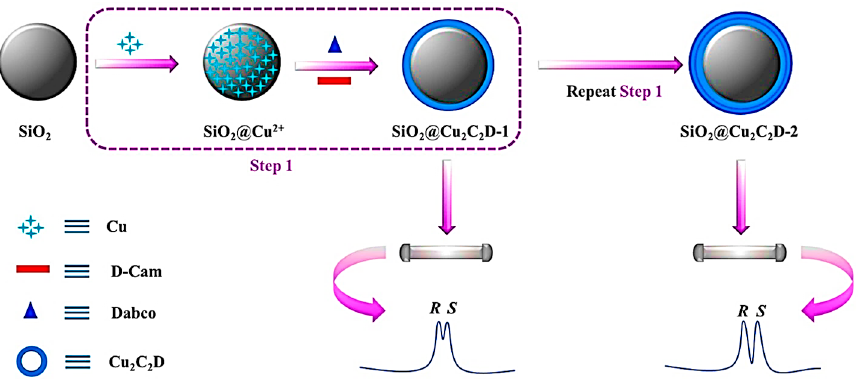
Figure 13. Schematic illustration of the fabrication process of SiO 2 @Cu 2 C 2 D. Reprinted (adapted) with permission from [121].